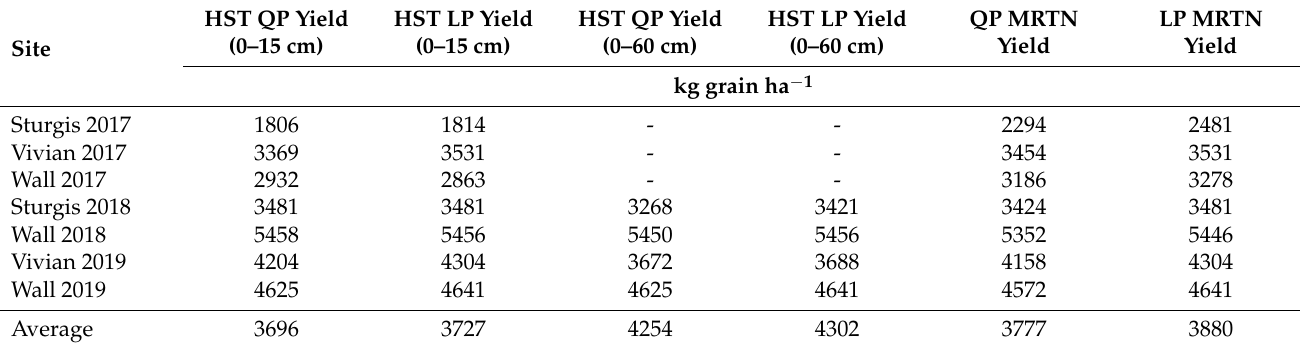
Table 4. Estimated grain yield (kg ha − 1 ) for the linear plateau (LP) and quadratic plateau (QP) models at the estimated Haney soil test (HST) and MRTN